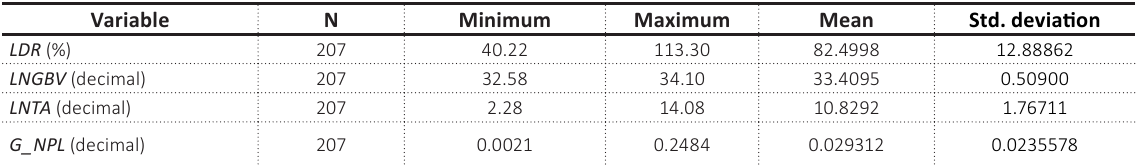
Table 4. The outcome of the classical assumption tests